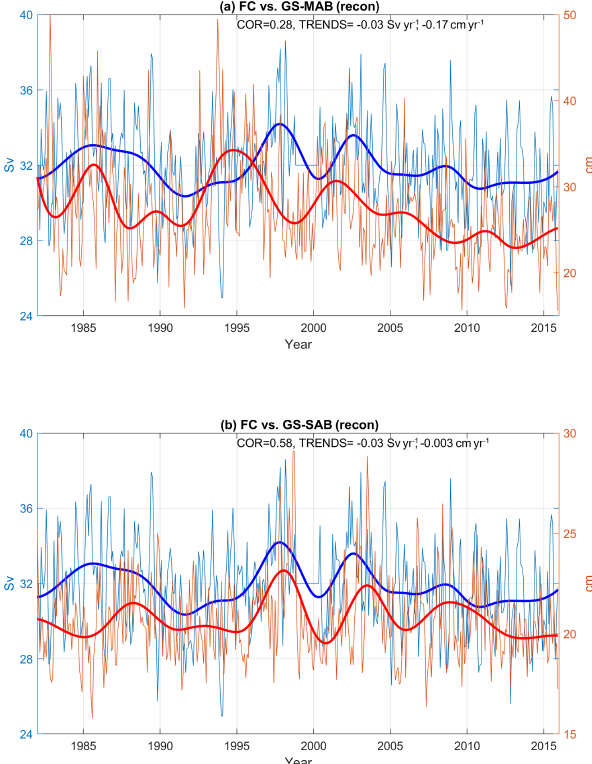
Figure 7. Comparisons between the observed monthly Florida Cur- rent transport (blue, in Sverdrup units on the left) and the GS proxy (red, in centimeter sea level change units on the right) obtained from the reconstructed sea level difference across the GS for (a) eastward velocity in the GS-MAB and (b) northward velocity in the GS-SAB. Thin lines are monthly values and, the heavy lines are low-pass- filtered records (sum of low-frequency EMD modes). The corre- lation of the low-frequency modes and the trends of the monthly records are